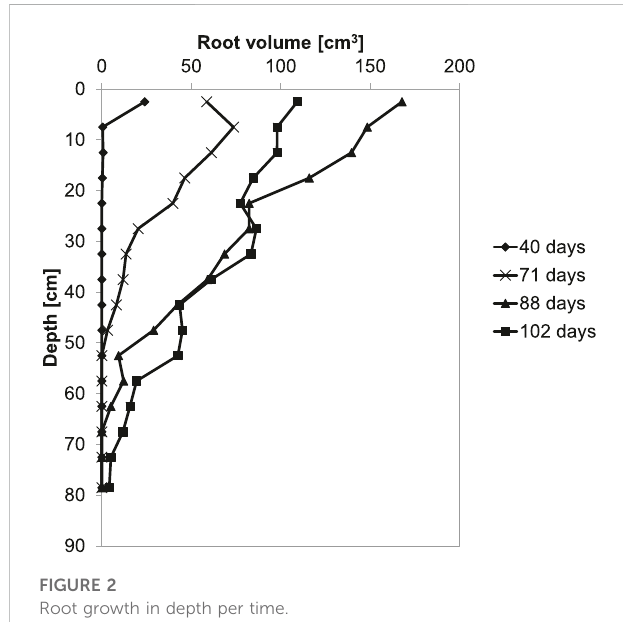
FIGURE 2 Root growth in depth per time.